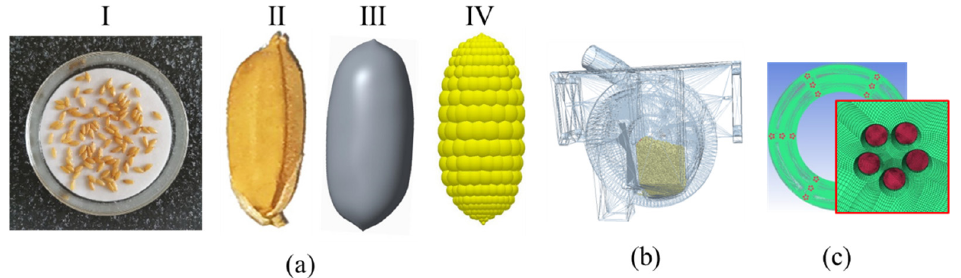
Figure 3. Simulation model: ( a ) rice seed model, I is overall “Suijing 18” seed, II is single “Suijing 18” seed, III is rice seed model established by reverse engineering, IV is discrete element model of rice seed; ( b ) model of seed metering device discrete element; ( c ) seed metering plate mesh model.